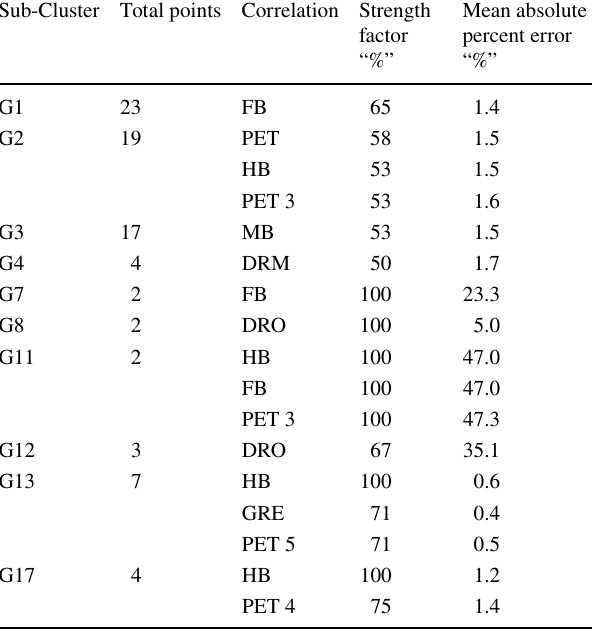
Table 13 Best correlations for cluster (E) Sub-cluster Total points Correlation Strength